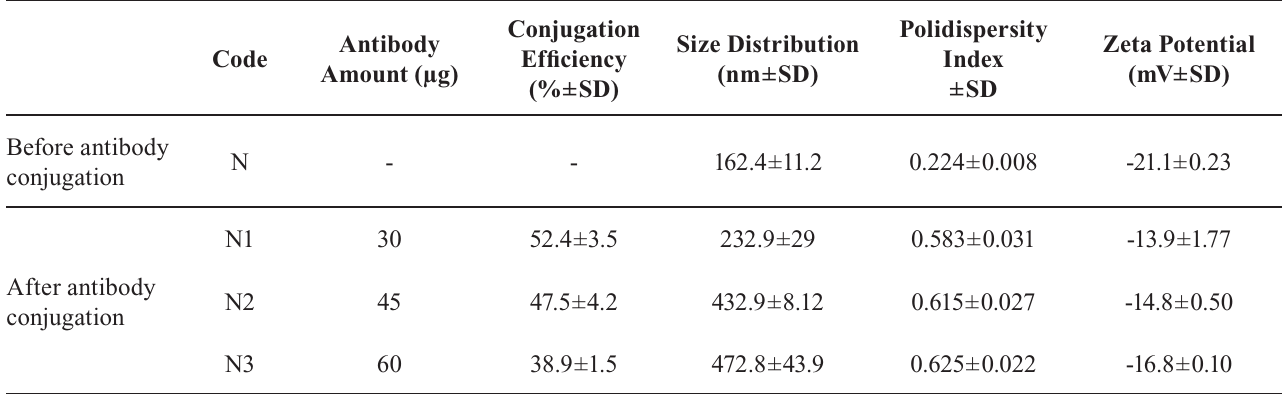
TABLE I - C ode, size distribution, polidispersity index and zeta potential of gold coated Fe antibody conjugation